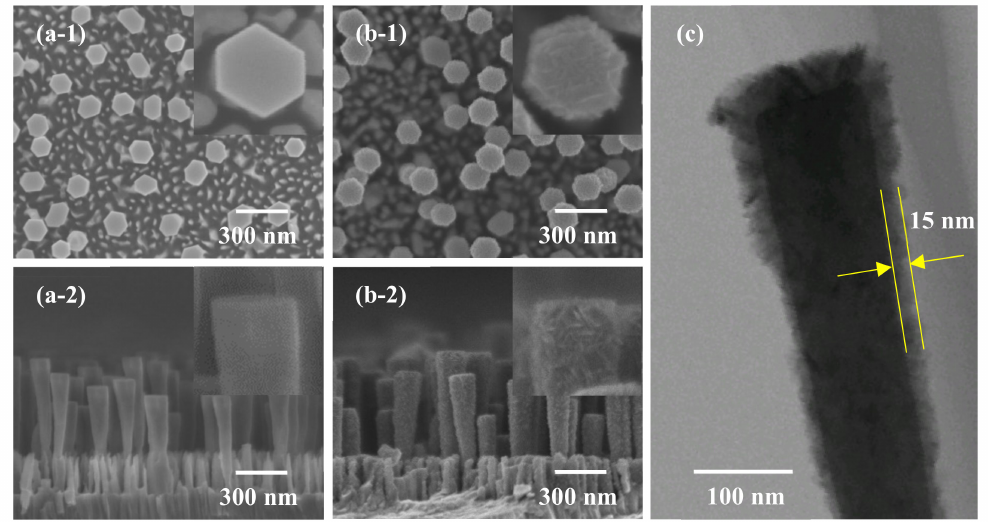
Figure 3. FE-SEM images of ( a ) as-deposited ZnO nanorods, ( b ) ZnO–TiO 2 core–shell nanorods, and ( c ) TEM image of single ZnO–TiO 2 core–shell nanorod (( 1 ) Top view, ( 2 ) cross-section